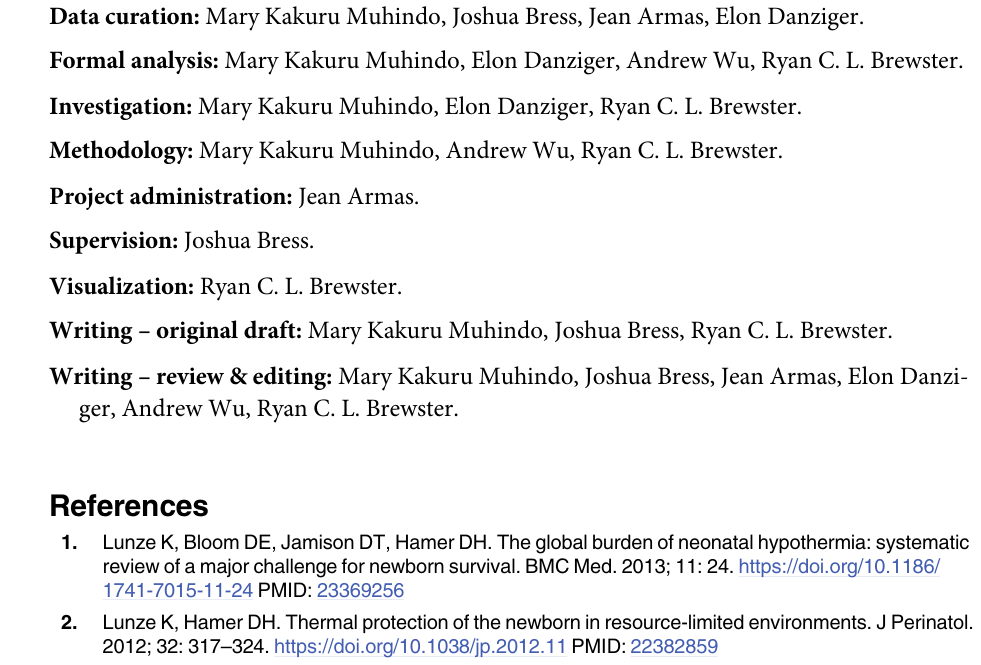
S1 Table. Definitions of clinical characteristics collected from the NoviGuide. S2 Table. Clinical characteristics of study population, by temperature. S3 Table. Clinical characteristics of study population, by assessment completion status. S1 Fig. Distribution of newborn temperatures entered into the NoviGude, by study site.